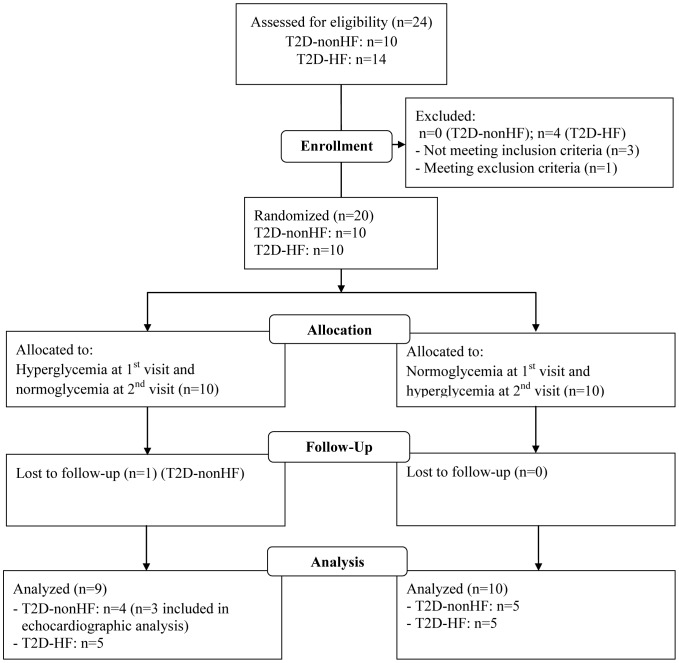
CONSORT diagram.